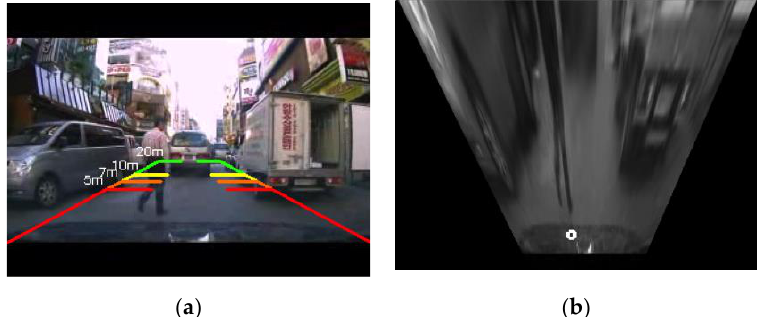
Figure 4. Transformation of the image from 2D to 3D. ( a ) Perspective 2D original image, ( b ) transformed 3D image: Because the distance should be computed in 3D view or top-view, the original perspective-view image is transformed using the homography transformation. Several distances (5 m, 7 m, 10 m, and 20 m) calculated in the transformed image are indicated on the original image, as shown in ( a ).